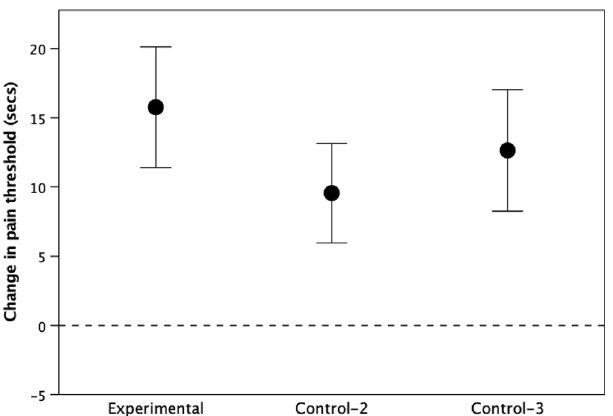
Figure 2. Mean (± 1 se) change in pain threshold following nodding in time to the same music as used in Experiment 1 (Experimental), nodding to arrhythmic nature sounds (control-2) or tapping a foot to the same music as in the experimental condition (control-3). Sample sizes are: 36, 32, 39 (L to